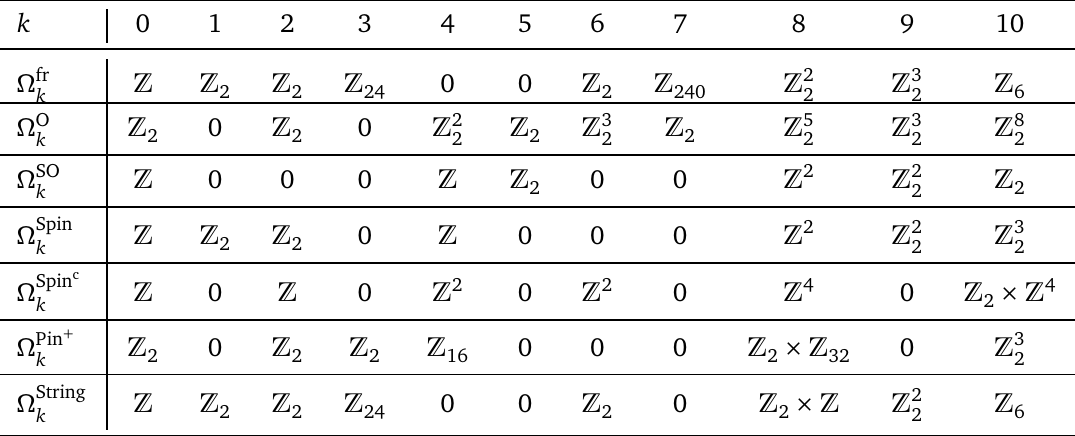
ξ for various dimensions k and ξ k